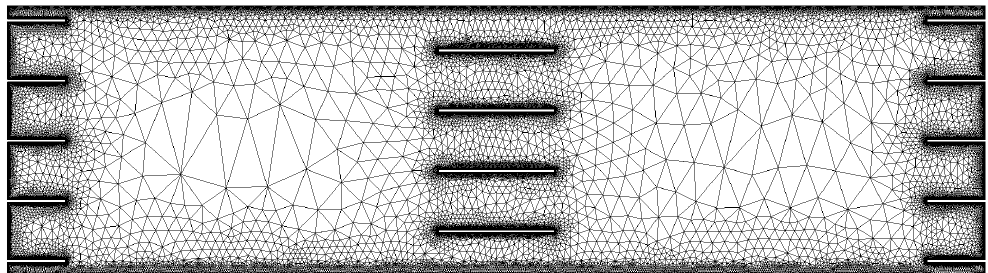
Figure 4. Example of a mesh for the numerical test setups. Dirichlet boundary conditions are defined at top and bottom edges of the mesh, while a periodic boundary condition is defined for left and right edges. The fillers are indicated by rectangular ’holes’ in the mesh, with only one filler per filler row. To improve visibility, the example contains only seven filler rows compared to the 100 filler rows in the numerical test